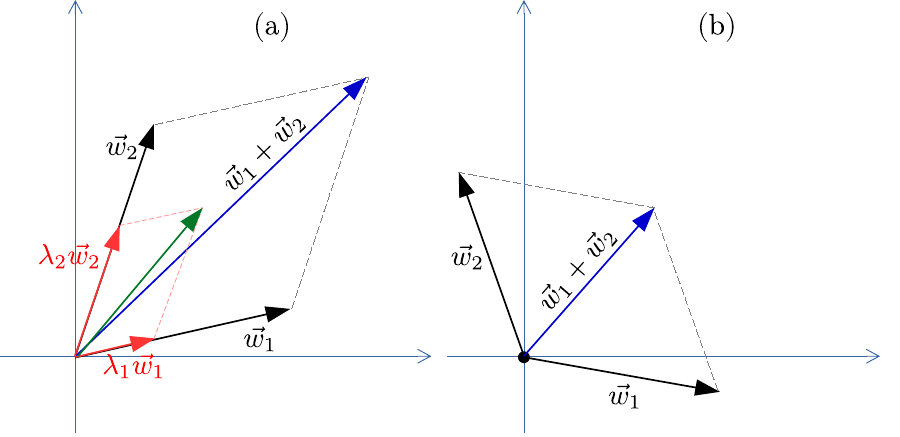
Figure 2. Graphical representation of the basic idea for the proposed ATMO optimizer. In ( a ), if the two translations (cid:126) w 1 and (cid:126) w 2 obtained from two different optimizers are similar, then the resulting translation (cid:126) w 1 + (cid:126) w 2 is boosted. In ( b ), if the translations (cid:126) w 1 and (cid:126) w 2 go in two different directions, then the resulting translation is smaller. We also use two hyper-parameters λ 1 and λ 2 to weigh the contribution of the two